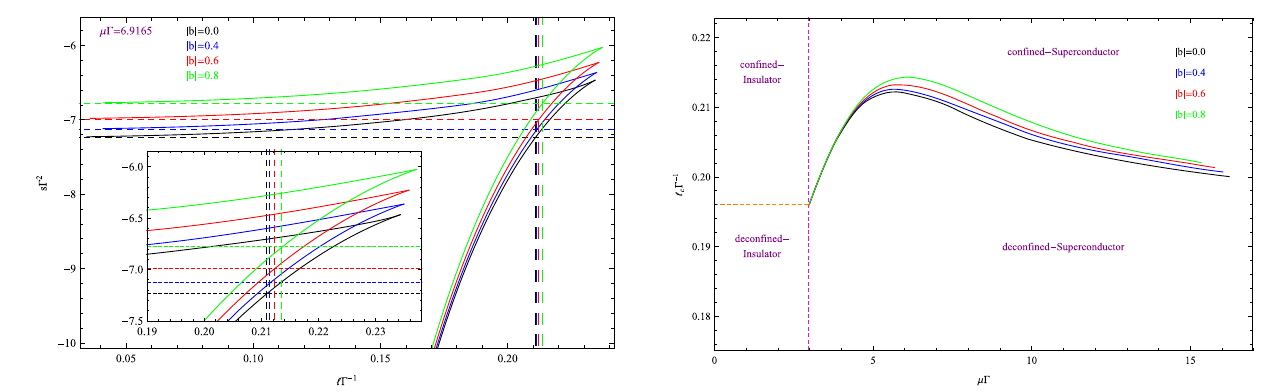
Fig. 4 TheHEEwithrespecttothestripwidth (cid:2) fordifferentparameter b with μ(cid:8) = 6 . 9165. The four curves from button to top correspond to increasing | b | , i.e., | b | = 0.0 (black), 0.4 (blue), 0.6 (red) and 0.8 (green) respectively. The corresponding critical widths are (cid:2) c (cid:8) − 1 = 0 . 2109, (cid:2) (cid:8) − 1 = 0 . 2122, (cid:2) (cid:8) − 1 = 0 . 2139, (cid:2) (cid:8) − 1 = 0 . 2164, respectively c c c